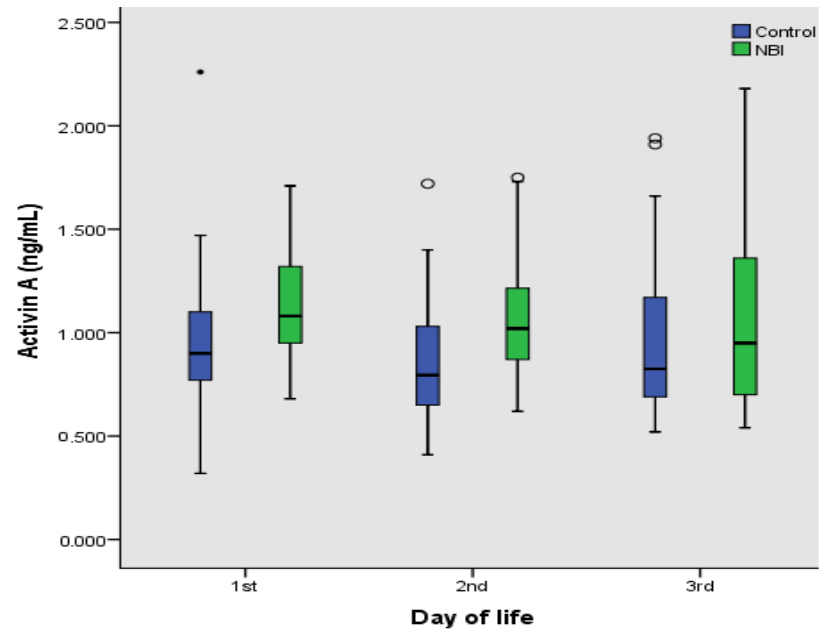
Figure 2. Box plots (horizontal line: median; box: 25–75% percentiles; whiskers: min–max; circles: outliers) of values of Activin A (ng/mL) in control and neonates with neonatal brain injury in (NBI) the first 3 days of life. Table 5. Concentrations of Activin-A (ng/mL) in the two studied groups, in the first 3 days of life (Mean ± Standard Deviation